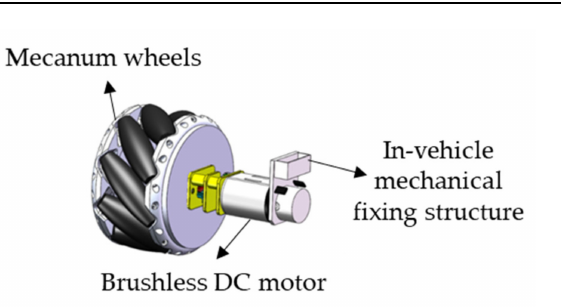
Figure 18. Connection mechanism of a DC motor with a Mecanum